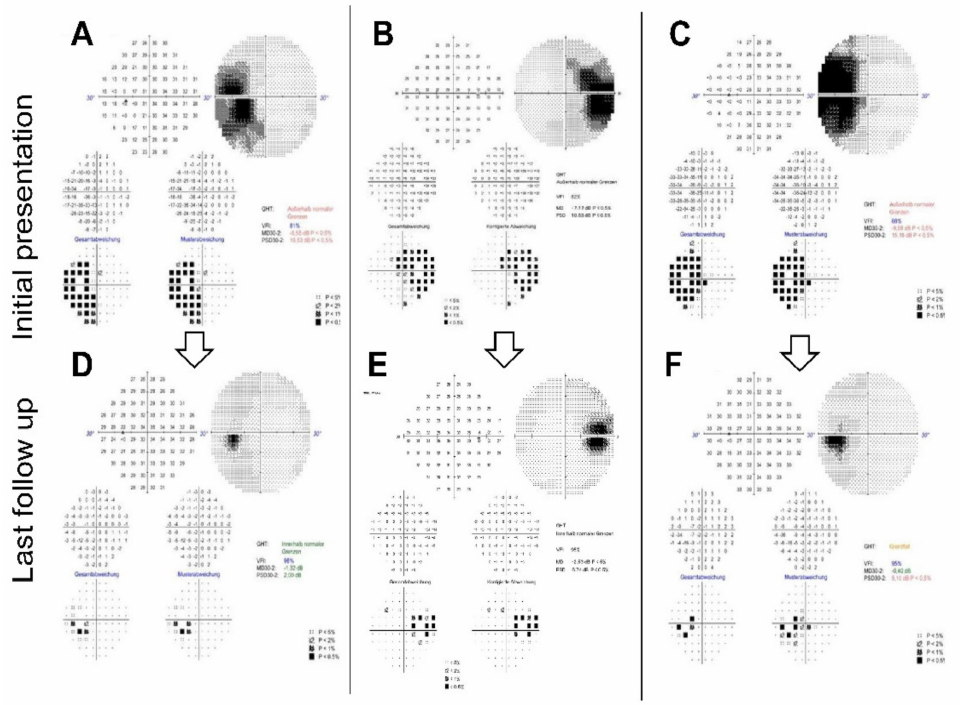
Figure 2. Static perimetry. Results of the 30-2 perimetry examination (Humphrey visual field analyser 3, Zeiss) of the affected eyes of cases 1–3 (from left to right) at first presentation ( A – C ) and at last follow-up, which was after six months in case 1 ( D ), after 12 months in case 2 ( E ) and after seven months in case 3 ( F ). Although all patients reported full recovery of their symptoms, discrete blind spot enlargement persisted in cases 2 and 3 ( E , F